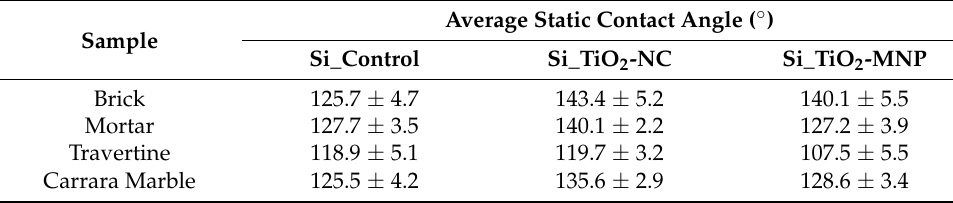
Table 2. Average static contact angle for all samples after